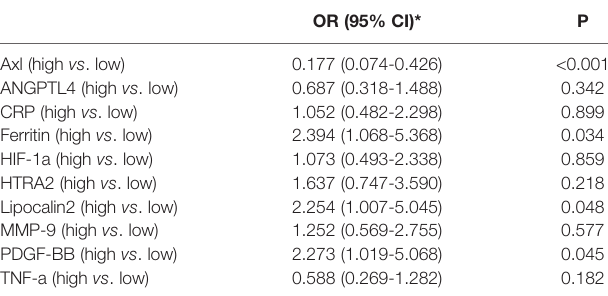
TABLE 3 | The Association between Multiple Protein Indexes and HT.